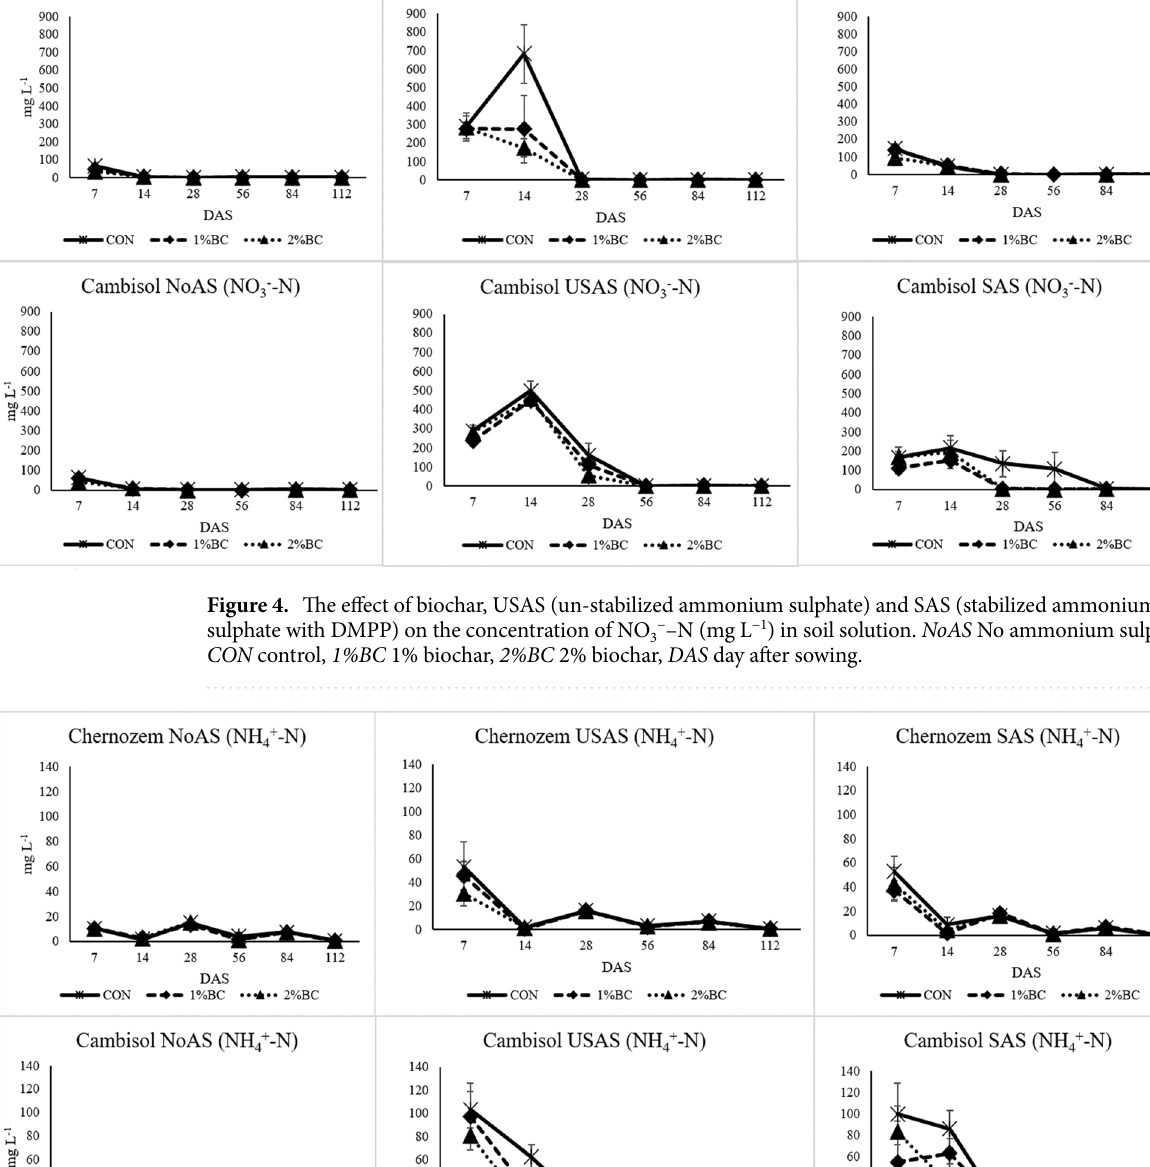
except for a slight decline in SAS and USAS treatments by the seventh DAS (SI S4). All the investigated factors except the interaction of soil with biochar had a significant effect on the concentration S in soil solution (SI S2). The greatest effect was from the application of fertiliser (F = 250, p < 0.001). Potassium, calcium and magnesium. All the factors investigated, except the interaction of biochar with fer- tiliser, had a significant effect on the concentration of K in soil solution, with the highest effect arising from the period of sampling F = 744, p < 0.001 (SI S2). A higher concentration of K was in the Cambisol than in the